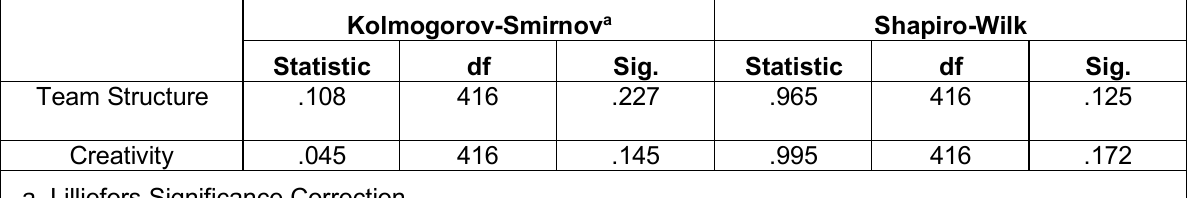
Table 1: Normality